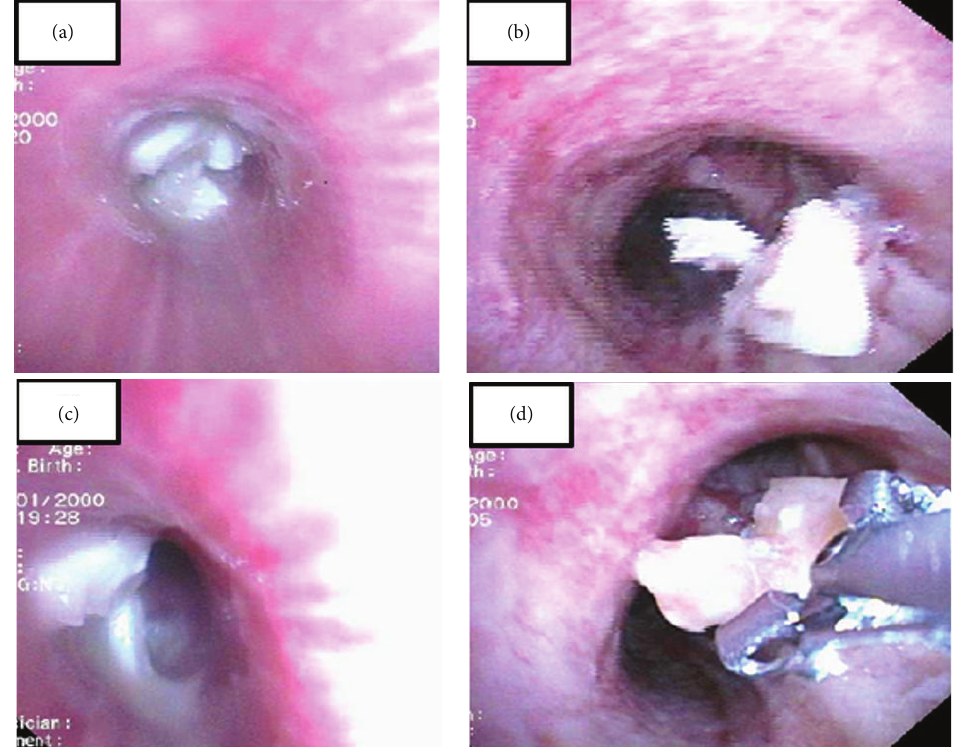
Figure 2: (a, c) Foreign body in the left main stem bronchus; (b) foreign body in the right main stem; (d) forceps retrieving the foreign